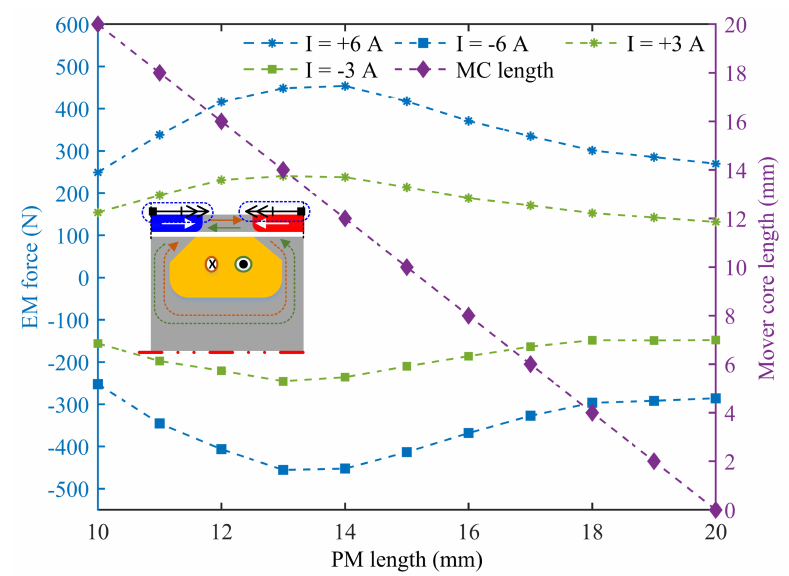
Figure 8. PM length and mover core length